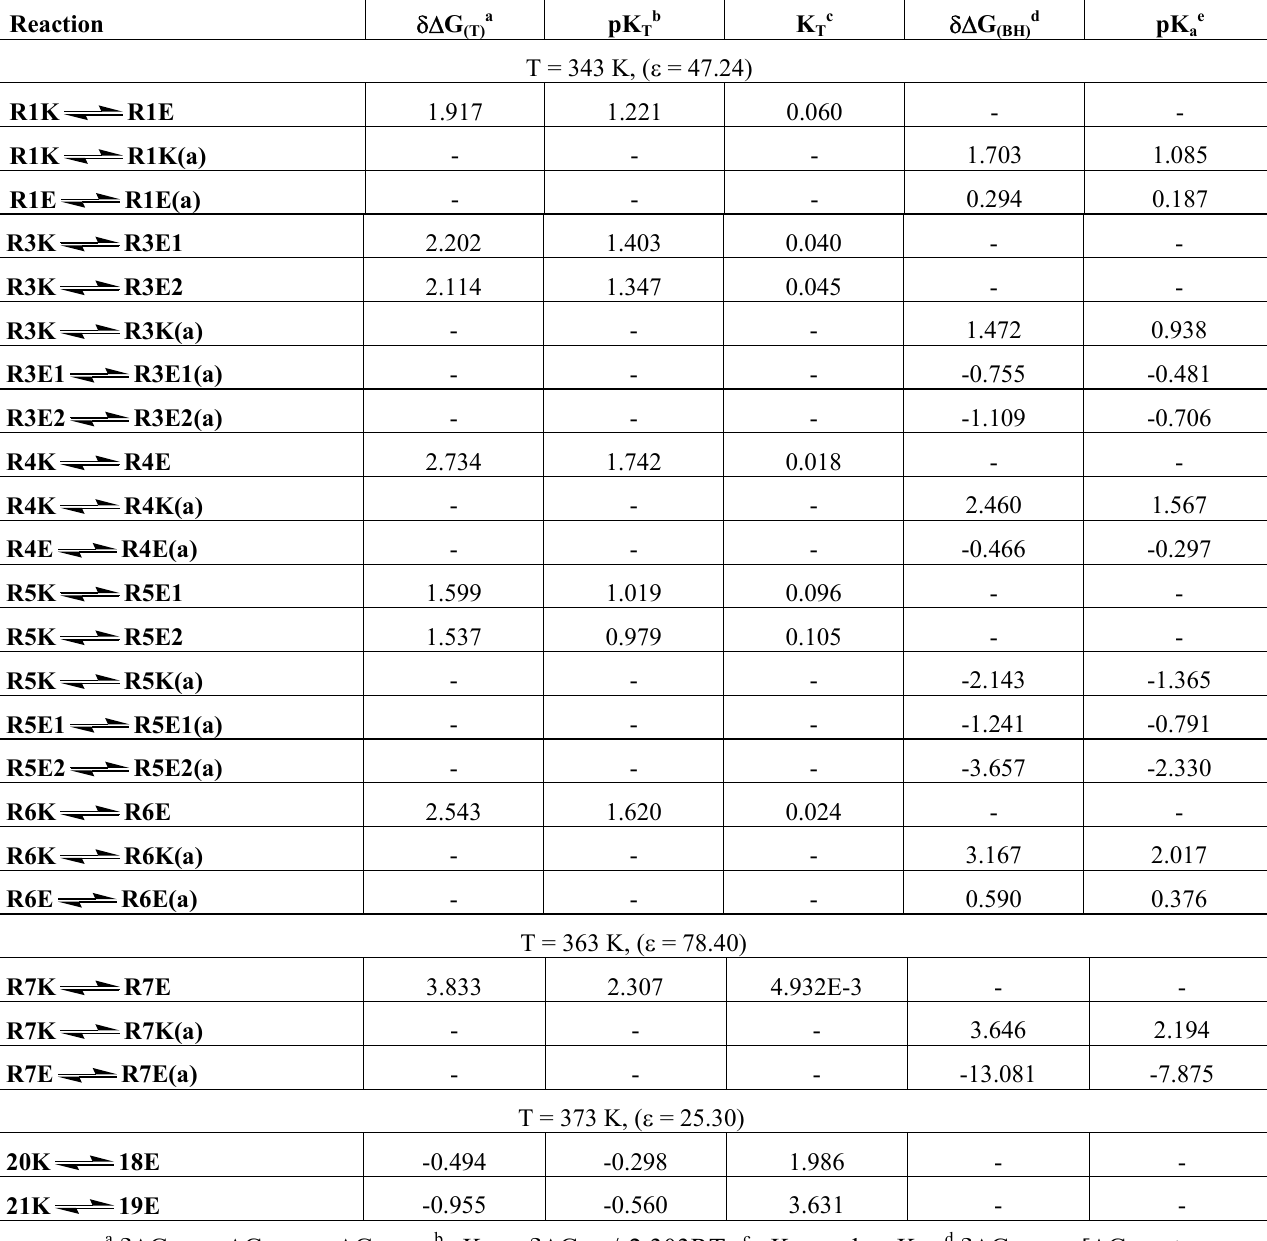
Table 2 . Liquid phase PM3 calculated physical parameters of studied molecules.